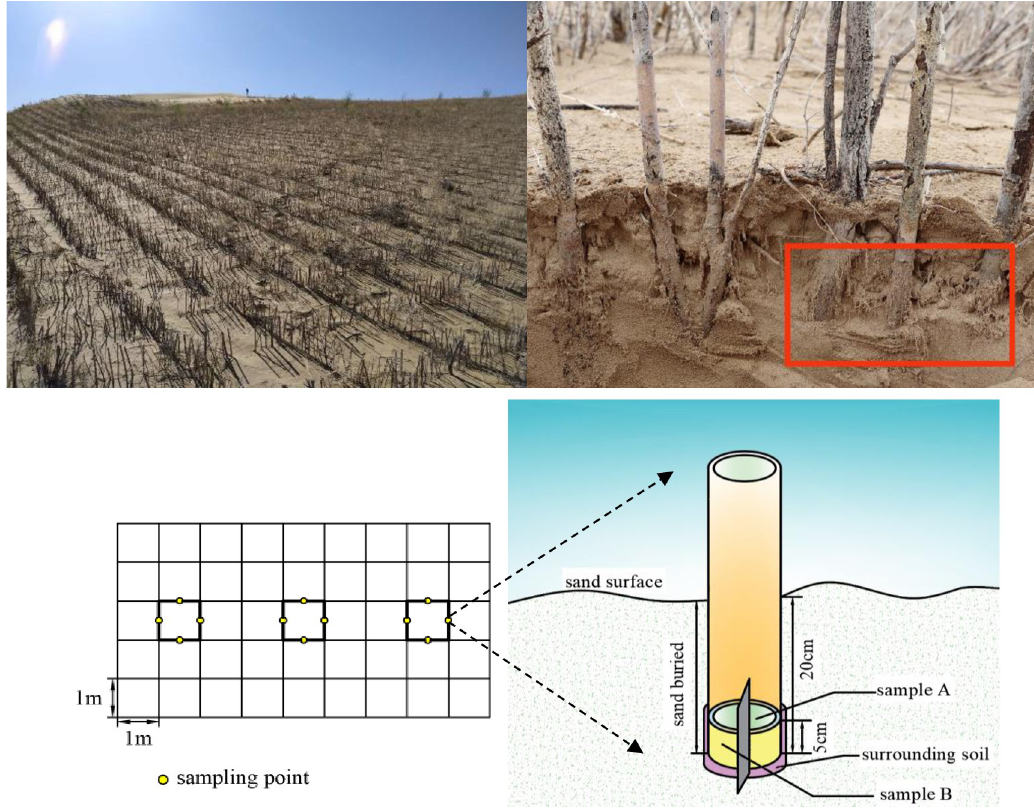
Fig 1. The schematic diagram for sample plots and sampling of S . psammophila sand barriers.